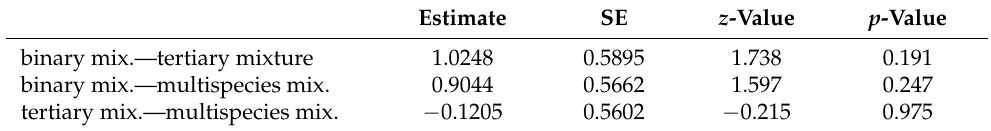
Table A3. Results of the Post hoc test analysing the differences of the ICE diversity index of the mixtures. Estimate